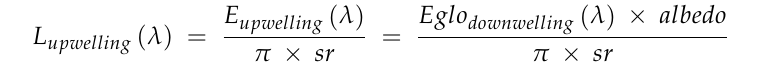
Figure 1. Illustration of the simulated locations. The exposure model takes into account the direct, diffuse, and reflected radiations, the complex geometry of a human body, and clothing. The albedo values of the location at 2200 m have been varied from 0.02 to 0.6. For a lower-altitude location at 600 m, an albedo of 0.02 was used.